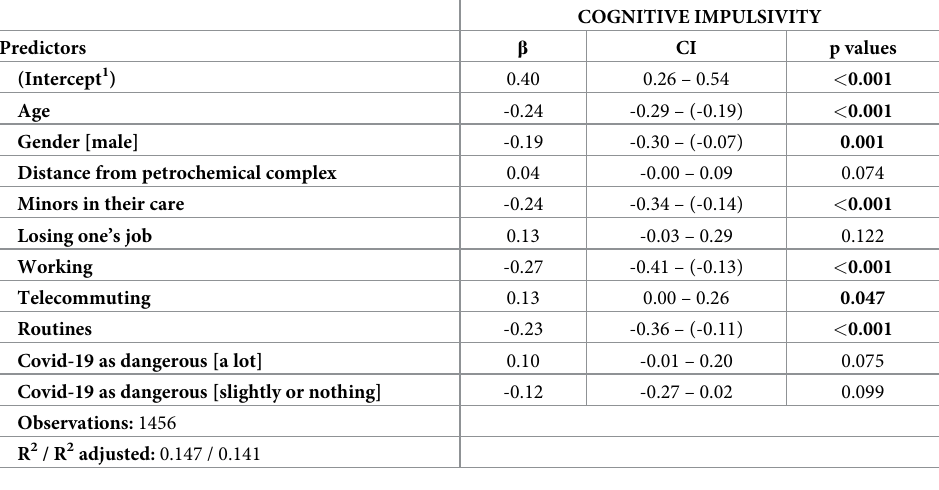
Table 10. Regression analysis relating to cognitive impulsivity in the BIS.